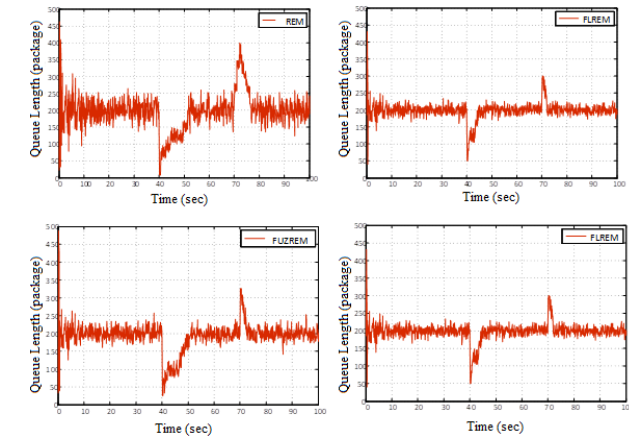
Figure 15. Ability to respond of REM, FUZREM,